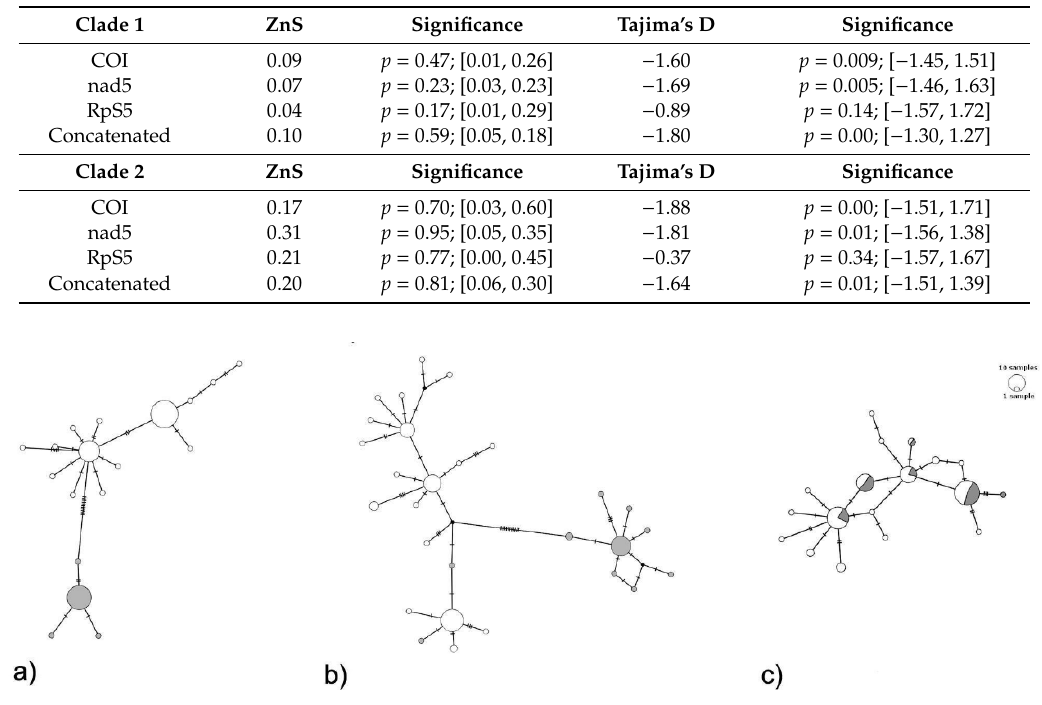
Figure 3. TCS haplotype network based on COI ( a ), nad5 ( b ) and RpS5 ( c ) amplicons of Prays oleae (circles, scaled to relative frequency of each haplotype in the data set). The white proportion in the circles correspond to the samples belonging to clade 1 and the grey part to clade 2 proportion according to COI phylogeny (Figure 2). COI ( a ) and nad5 ( b ) networks show the occurrence of clade 1 and clade 2, while RpS5 ( c ) might evolve too slowly to resolve the two clades.